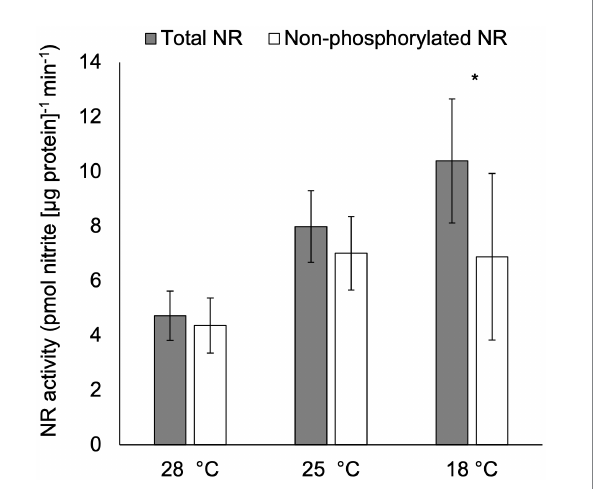
FIGURE 4 Activity (pmol nitrite [ μ g protein] − 1 min − 1 ) of total NR and non- phosphorylated NR in C. subsalsa acclimated to different temperatures (28 ° C, 25 ° C, and 18 ° C) in the long-term temperature experiment. Samples for NR activity assay were collected at 6 h after lights on. Asterisk (*) reveals the significant difference in NR activity between total and non-phosphorylated NR, indicating the regulation by reversible phosphorylation and the subsequent binding of putative 14-3-3 proteins, at the indicated temperature ( p < 0.05). Error bars are standard deviation of three biological replicates.